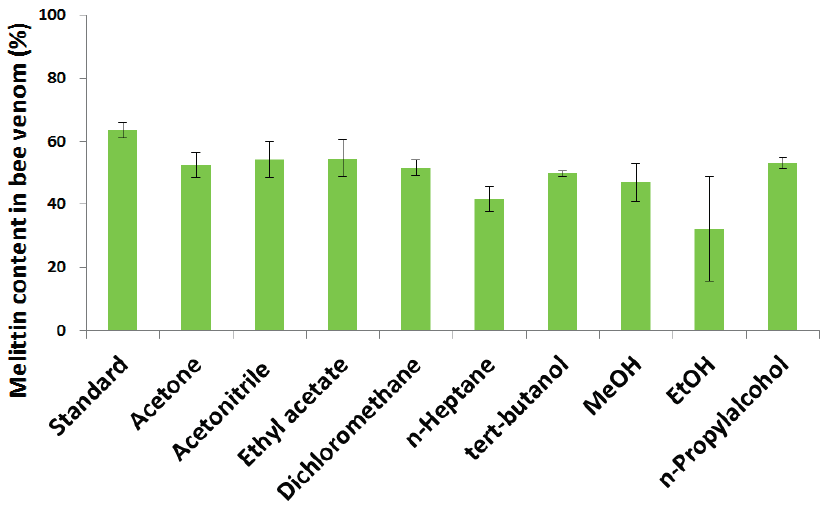
Figure 5. Effect of organic solvents on bee venom; Data are expressed as the mean ± SD ( n =